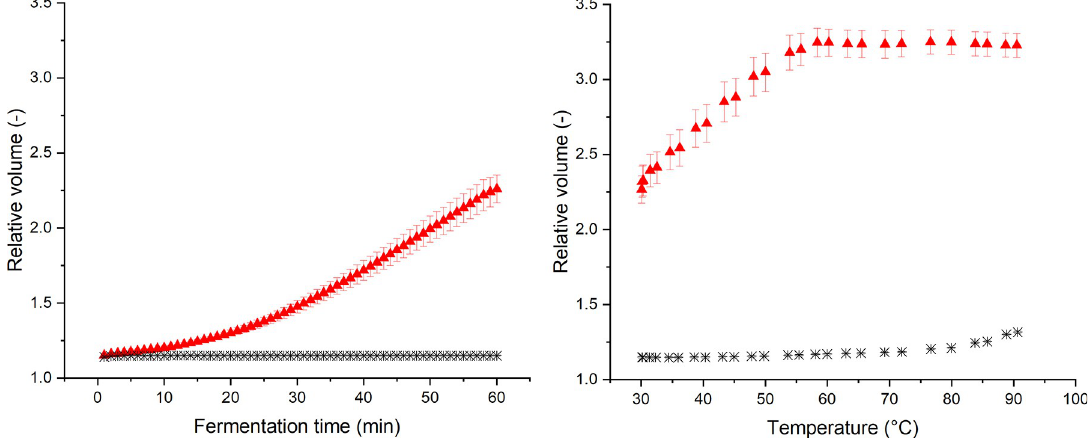
Fig 6. Relative volume of yeasted dough and non-yeasted standard wheat dough during 60 min fermentation at 30˚C and subsequent heating to 90˚C. a) Time dependency of the relative volume during the fermentation process. b) Temperature dependency of the relative volume during the heating process. ( � ) Standard non-yeasted wheat dough and ( ▲ ) yeasted wheat dough (1 g fresh yeast/ 100 g flour). (n � 3, � X � ±